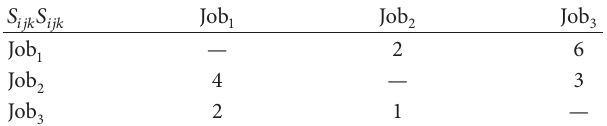
Table 3: Setup times for Machine